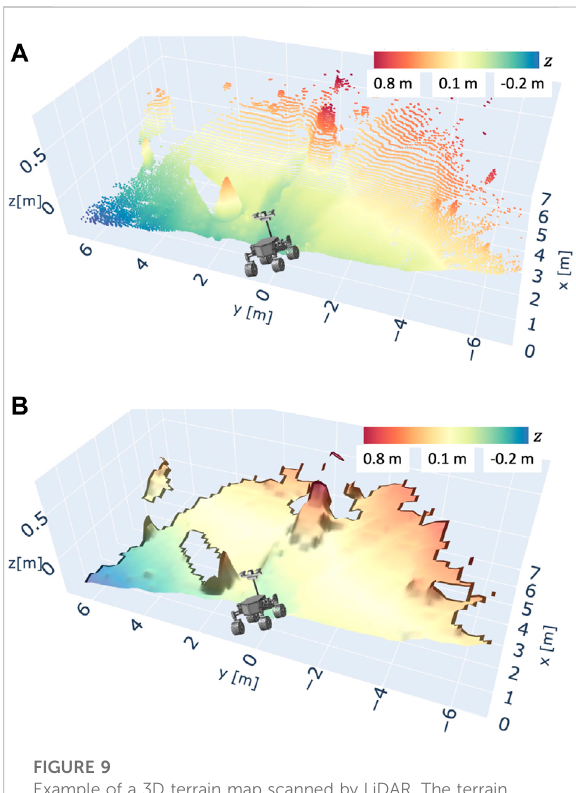
FIGURE 9 Example of a 3D terrain map scanned by LiDAR. The terrain surface is scanned from the location of the illustration of the rover testbed. (A) Raw point cloud data scanned by LiDAR, (B) DEM converted from the raw point cloud